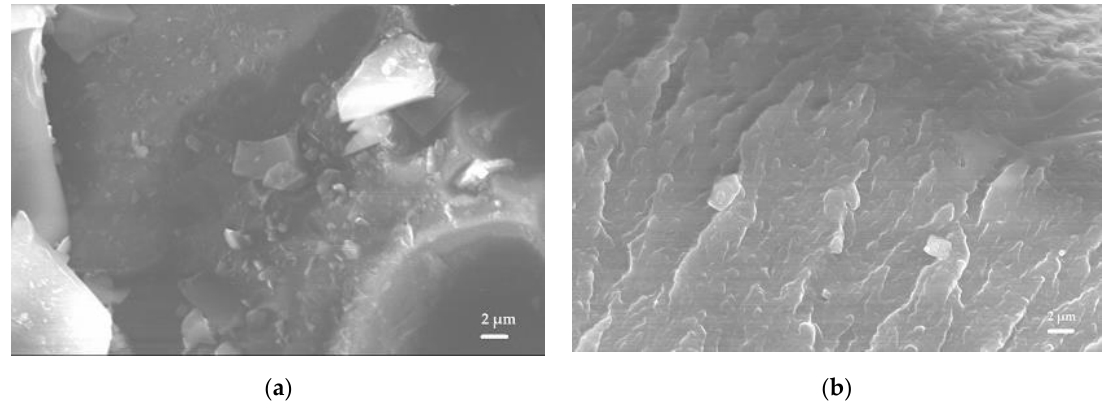
Figure 8. FTIR spectra of vancomycin: original, and after interaction with Na 2 HPO 4 ·12H 2 O. slowed down over time, but did not reach a plateau within 75 h. Vancomycin, dissolving inside the matrix in liquid, exited through interconnected pores. The greater the surface area (i.e., the On the surface of the vancomycin particles, when exposed to sodium hydrophos- greater the open porosity), the higher the rate of antibiotic release (Figure 12). phate salt, surges formed (Figure 9).